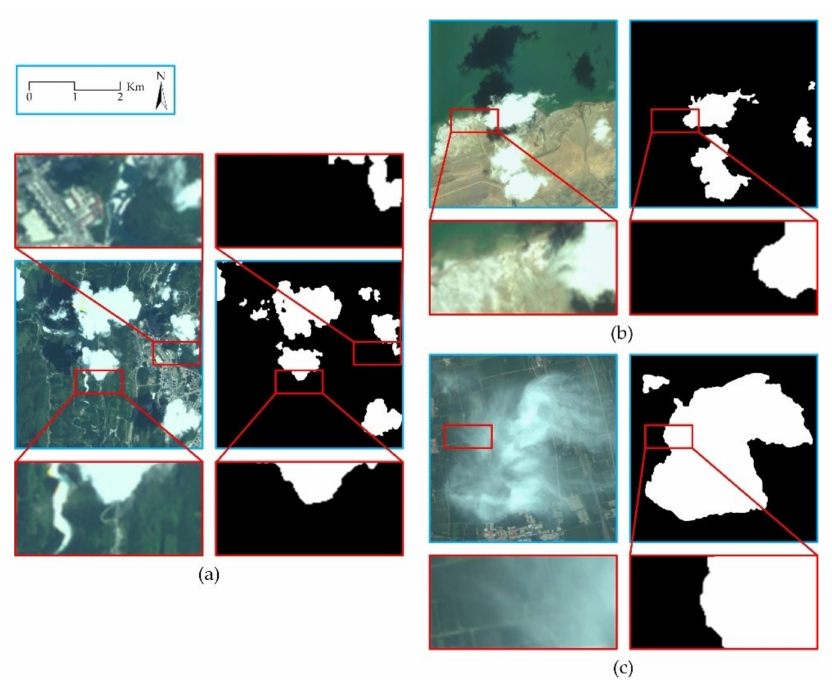
Figure 9. The cloud-detection results under different scenes. ( a ) The original image and the detection result of Scene I; ( b ) the original image and the detection result of Scene II; ( c ) the original image and the detection result of Scene III. The coordinates of ( a ) are 107.7E and 28.5N, ( b ) 89.6E and 32.8N, ( c ) 117.0E and